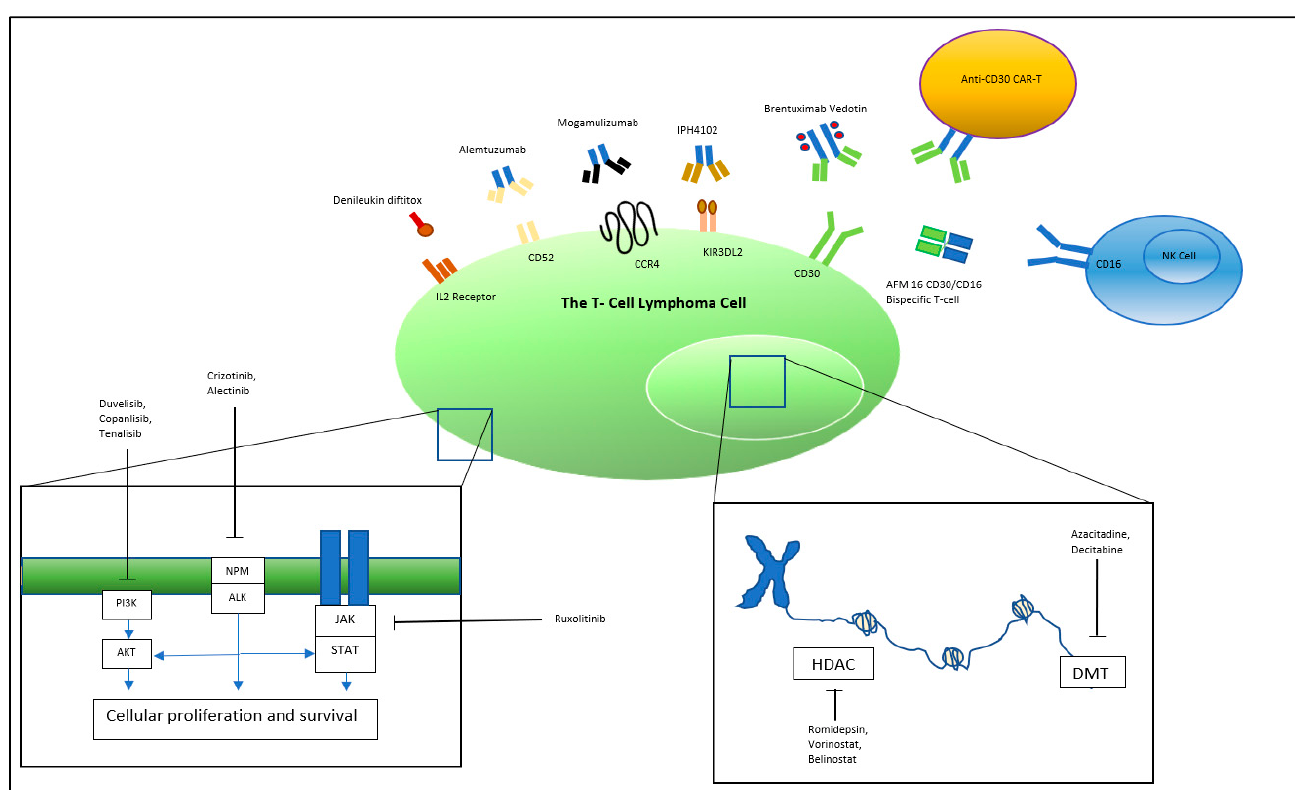
Figure 1. Targets of novel T-cell lymphoma therapy. PI3K, Phosphoinositide 3-kinase; NPM, Nucleophosmin; ALK, Anaplastic lymphoma kinase; JAK, Janus kinases; STAT, signal transducer and activator of transcription proteins; HDAC, Histone deacetylase; DMT, DNA methyltransferase.